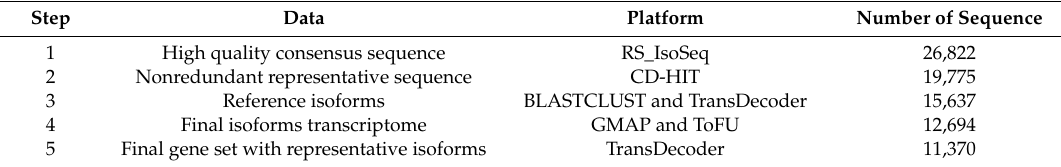
Table 1. Summary of platforms used establishing gene set in kenaf.